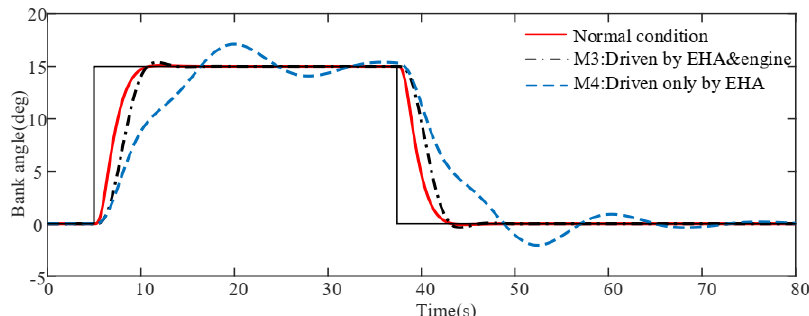
Figure 9. Bank angle response for damage scenario II.